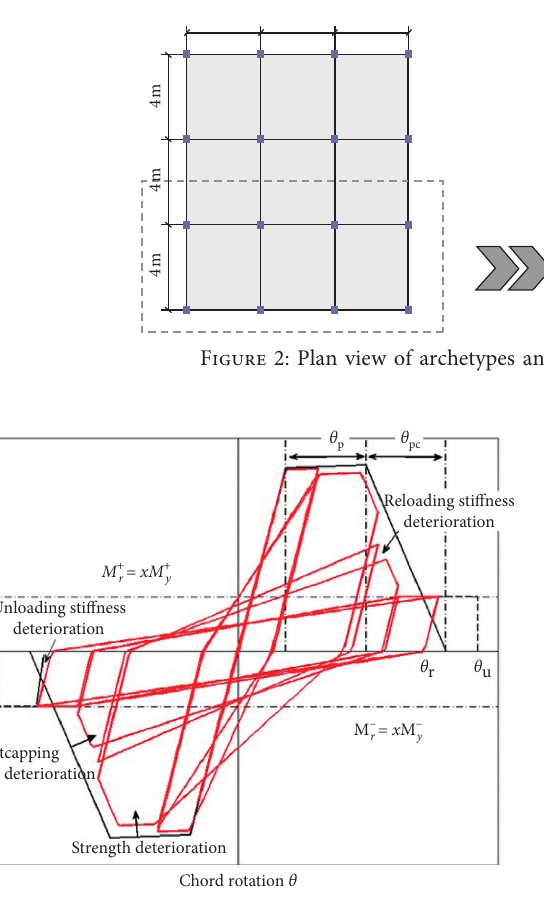
Figure 3: Backbone curve and cyclic behavior of the RC beam- column plastic hinge model